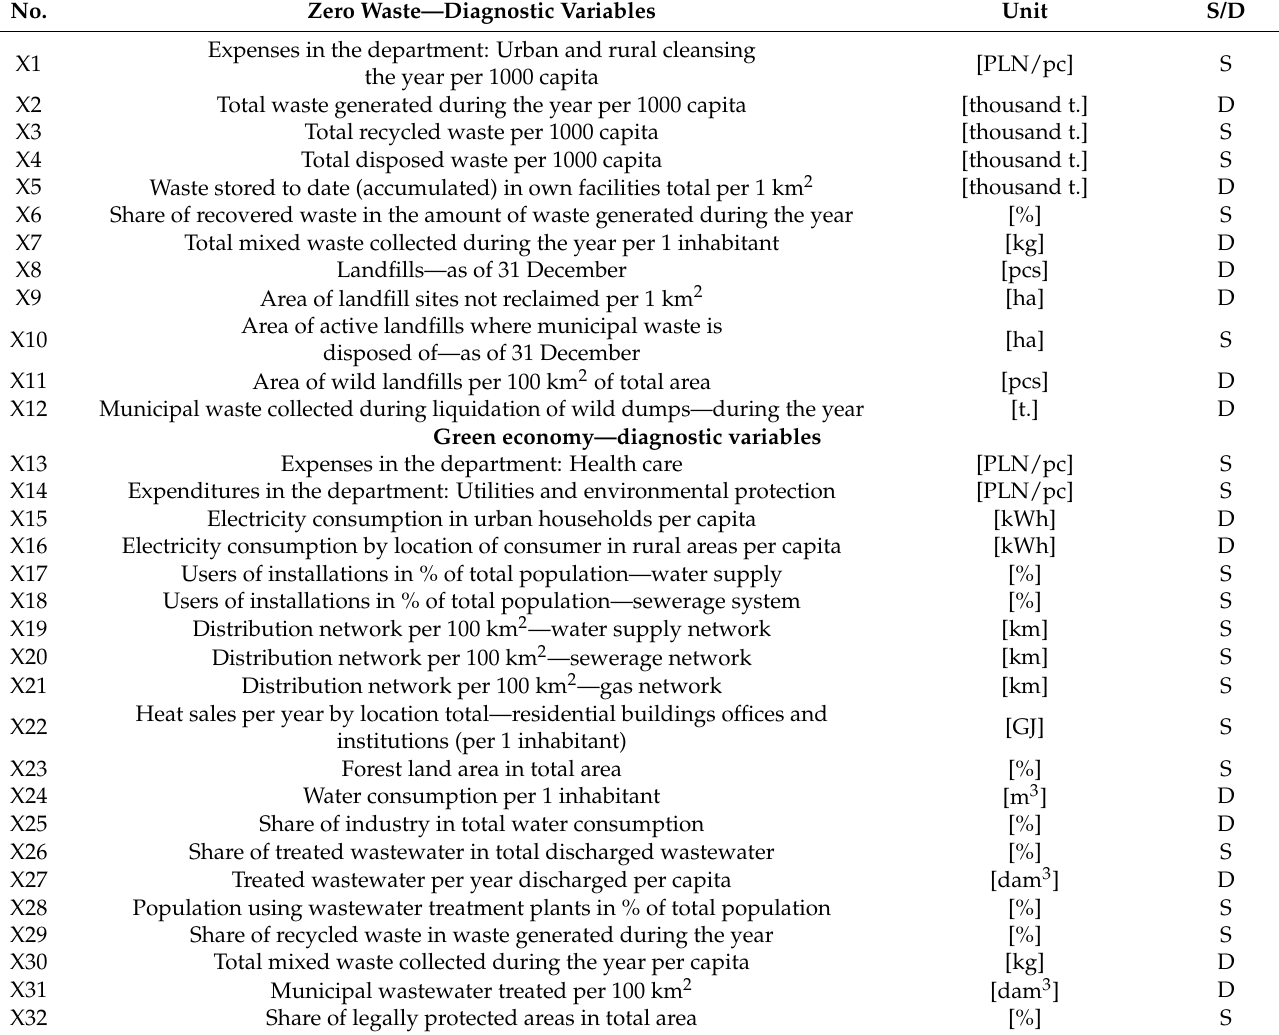
Table 1. Diagnostic variables describing zero west and green economy at the level of